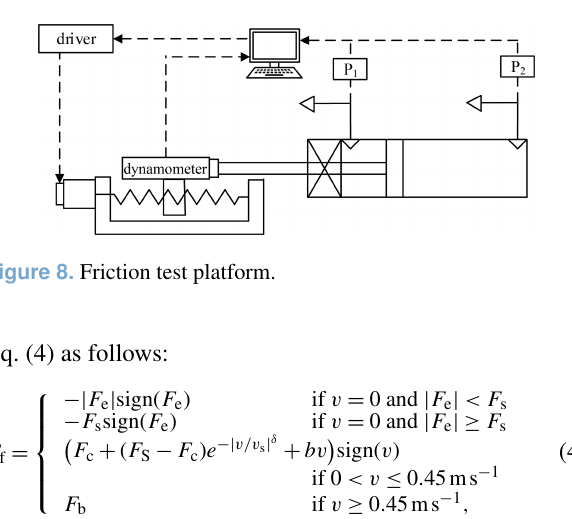
Figure 7. Displacement curve of piston rod braking under different initial velocities.